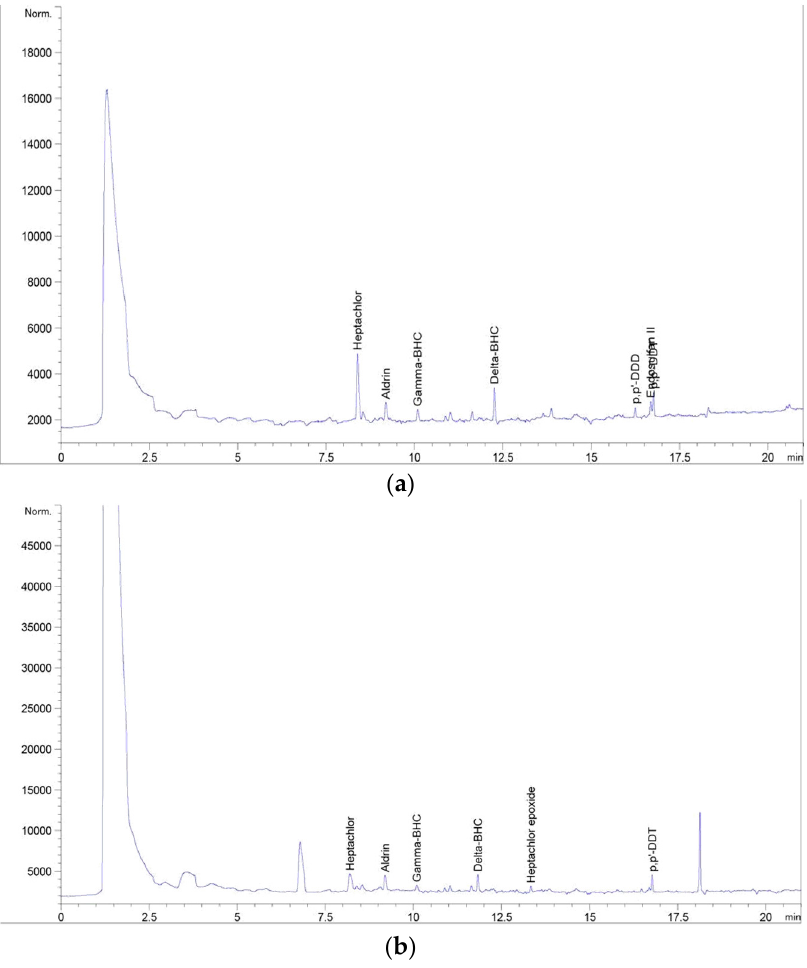
Figure 1. ( a , b ) Representative chromatograms of the samples. Table 2. Mean concentration (mg/kg) of benzene hexachloride in the cocoa beverages.